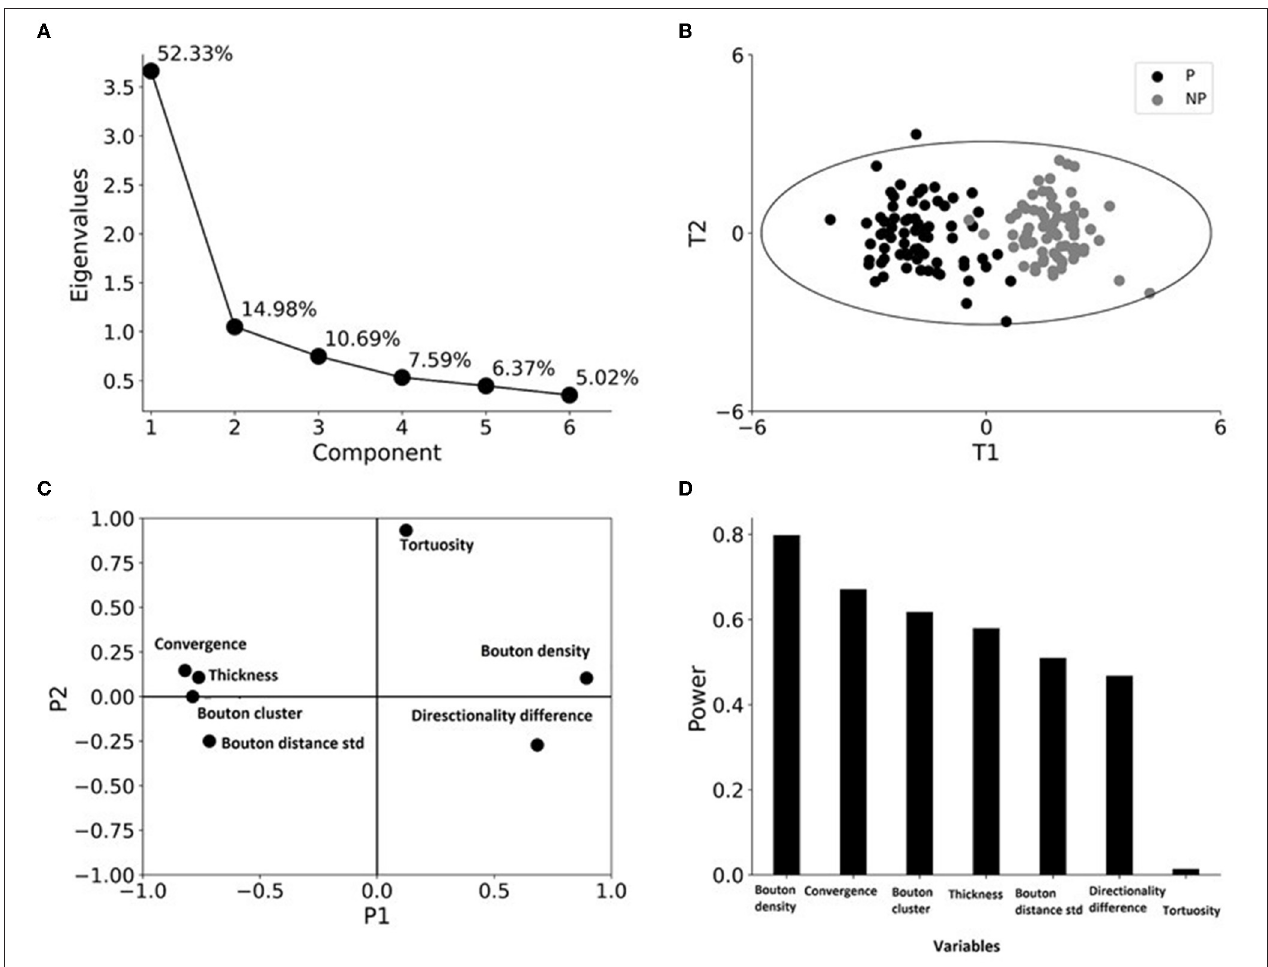
FIGURE 5 | Principal component analysis (PCA) identifies clustering only by patch designation. (A) A scree plot showing the eigenvalues and the percentage of variance explained by the six principal components. (B) Case-wise analysis shows the tendency of the grouping of patch (P) and no-patch (NP) axons, black and gray circles, respectively, along the two principal components. Distribution of scores (distances of the transformed values of the variables from the origin along the PCs) of axons for the first principal component (T1) plotted against the scores for the second principal component (T2). The ellipse outlines ± 3 SD and indicates the presence of a single patch outlier in the data set. (C) Distribution of loading factors (transformed values showing the contribution of the variable to the PCA model) P1 and P2 for the first and second principal components. The greater a variable is away from zero, the more influence that variable has. A diagonal position in opposite quadrants means a negative correlation between the variables. (D) The importance of the variables is measured by the modeling power, which is defined as the SD